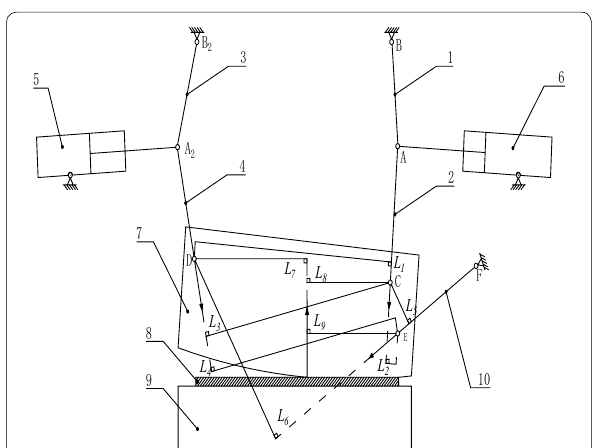
Figure 1 Hydraulic shear mechanism diagram. 1, 3: putter; 2, 4: link;